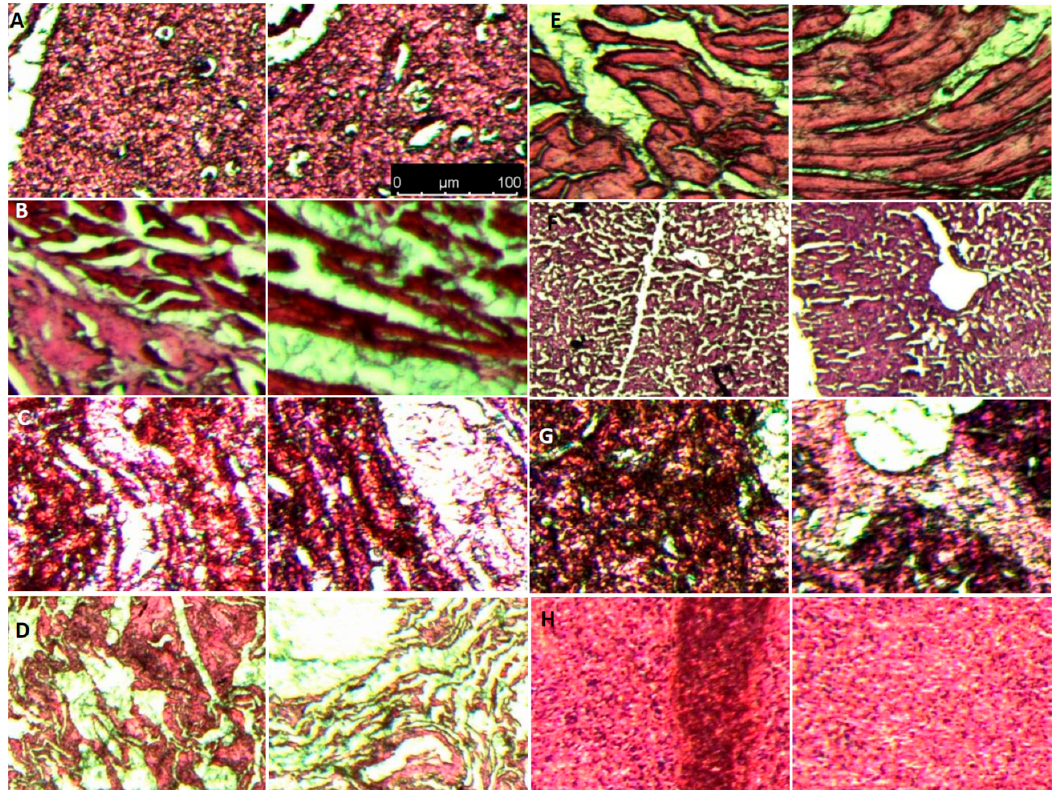
Figure 7. Histological evaluation of In vivo organ toxicity with histopathological staining on organ sections. ( A ) Brain ( B ) Heart ( C ) Kidney ( D ) Lung ( E ) Muscle ( F ) Liver ( G ) Pancreases ( H ) Spleen. Each image from A – H has control (left panel) and sca ff old applied (right panel) sample section with Hematoxylin and Eosin ( H , E )